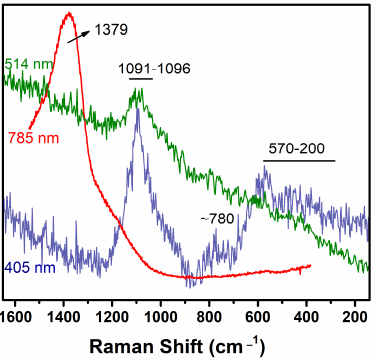
Figure 2. Raman spectra at room temperature of calcined Ns SiO 2 using excitation wavelengths at 405, 514 and 785 nm. 405, 514 and 785